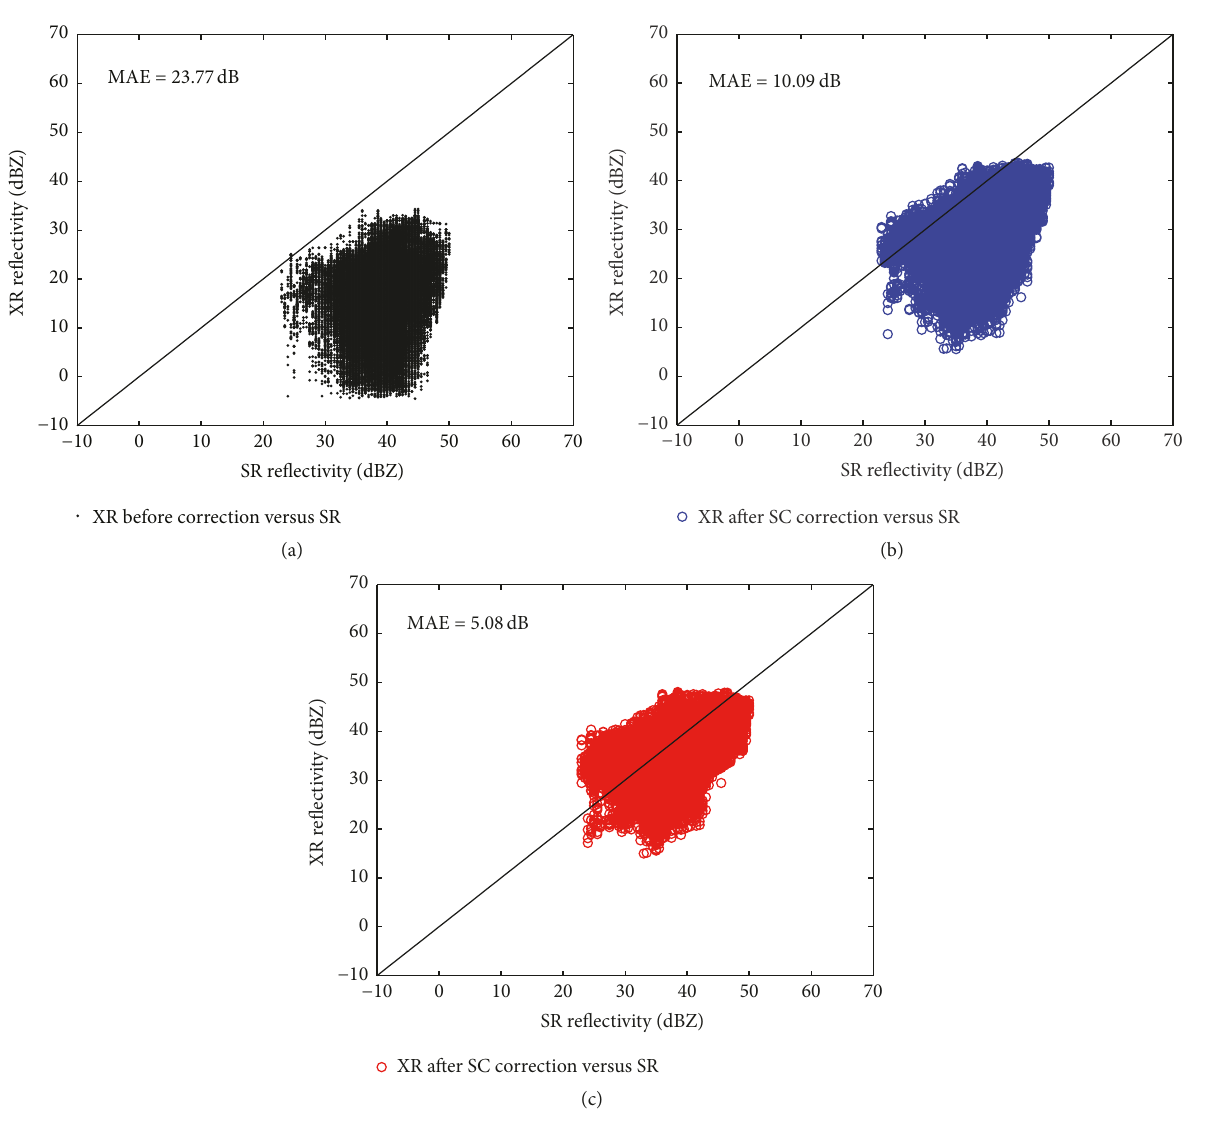
Figure 11: Scatter plot of (a) the XR reflectivity before attenuation correction against the SR reflectivity, (b) the XR reflectivity after SC correction against the SR reflectivity, and (c) the XR reflectivity after ACML correction against the SR reflectivity. All the reflectivities were in the azimuth range from 228 ∘ to 237 ∘ within the range of 44 and 60km during 0640 to 0842 UTC. The mean absolute errors (MAEs) are also shown in the